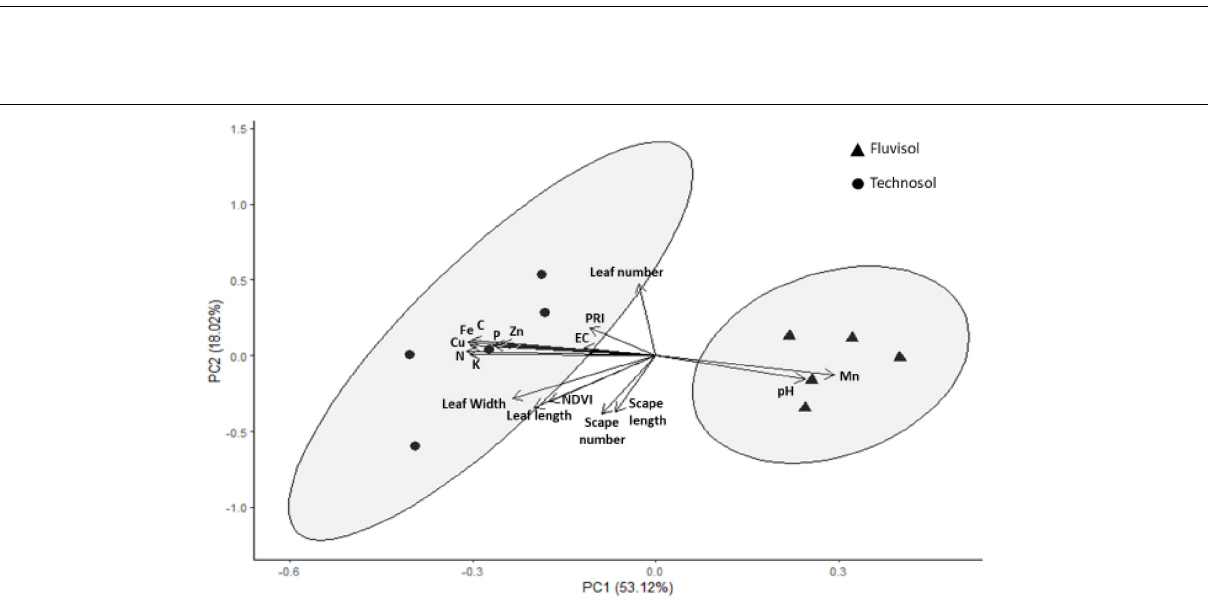
Frontiers in Ecology and Evolution |